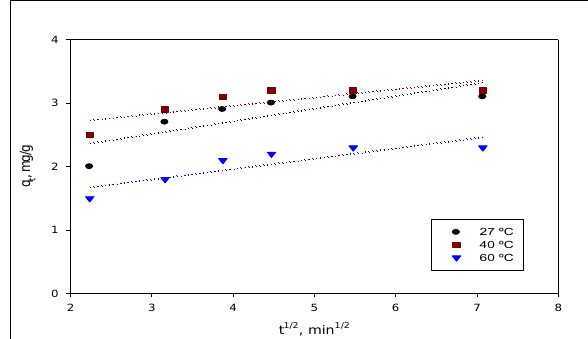
Figure 4: Intraparticle diffusion adsorption kinetics of phenol on SBFA.